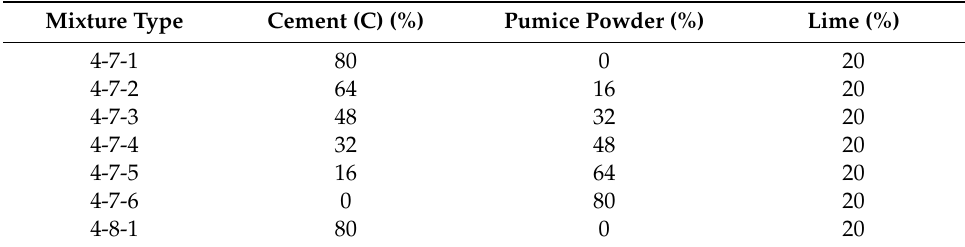
Table 13. Type 4-7 mixing ratios.